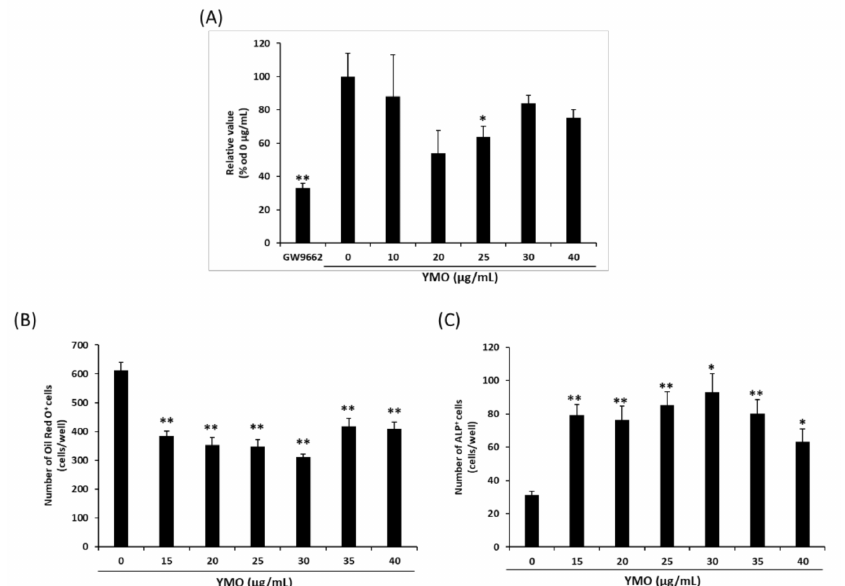
Figure 1. Effect of YMO on peroxisome proliferator activated receptor γ (PPAR γ ) transcriptional activity and differentiation of C3H10T1/2 cells. ( A ) Effect of 0–40 µ g/mL YMO on PPAR γ transcrip- tional activity in the presence of 5 µ M troglitazone. Relative luciferase activities were expressed as percentage of vehicle control. ( B , C ) Effect of 0–40 µ g/mL YMO treatment for 14 days on differen- tiation of C3H10T1/2 cells. A number of Oil Red O + cells ( B ) and of ALP + cells ( C ) in each well were counted under light microscope. Values are mean ± SE, n = 4–5. ** p < 0.01, * p < 0.05 versus 0 µ